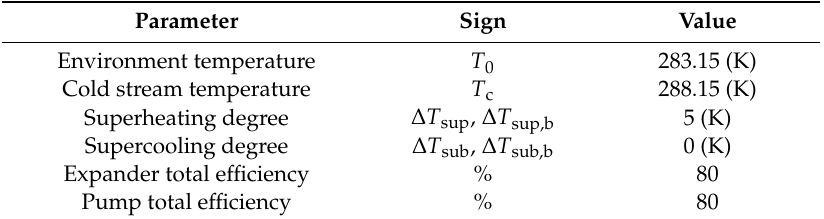
Table 3. Main assumptions for DORC